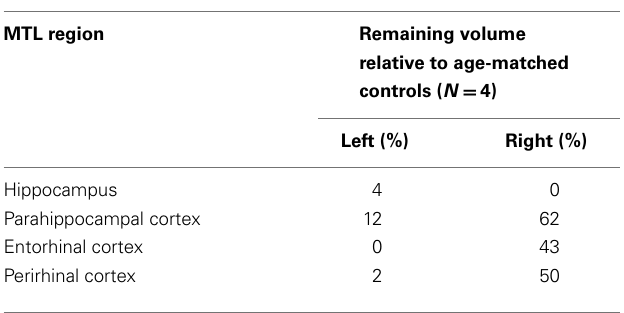
Table 2 | LSJ’s performance on theWAIS-IV,WMS-III, and MBEA [for full neuropsychological test profile see Gregory et al. (2014)]